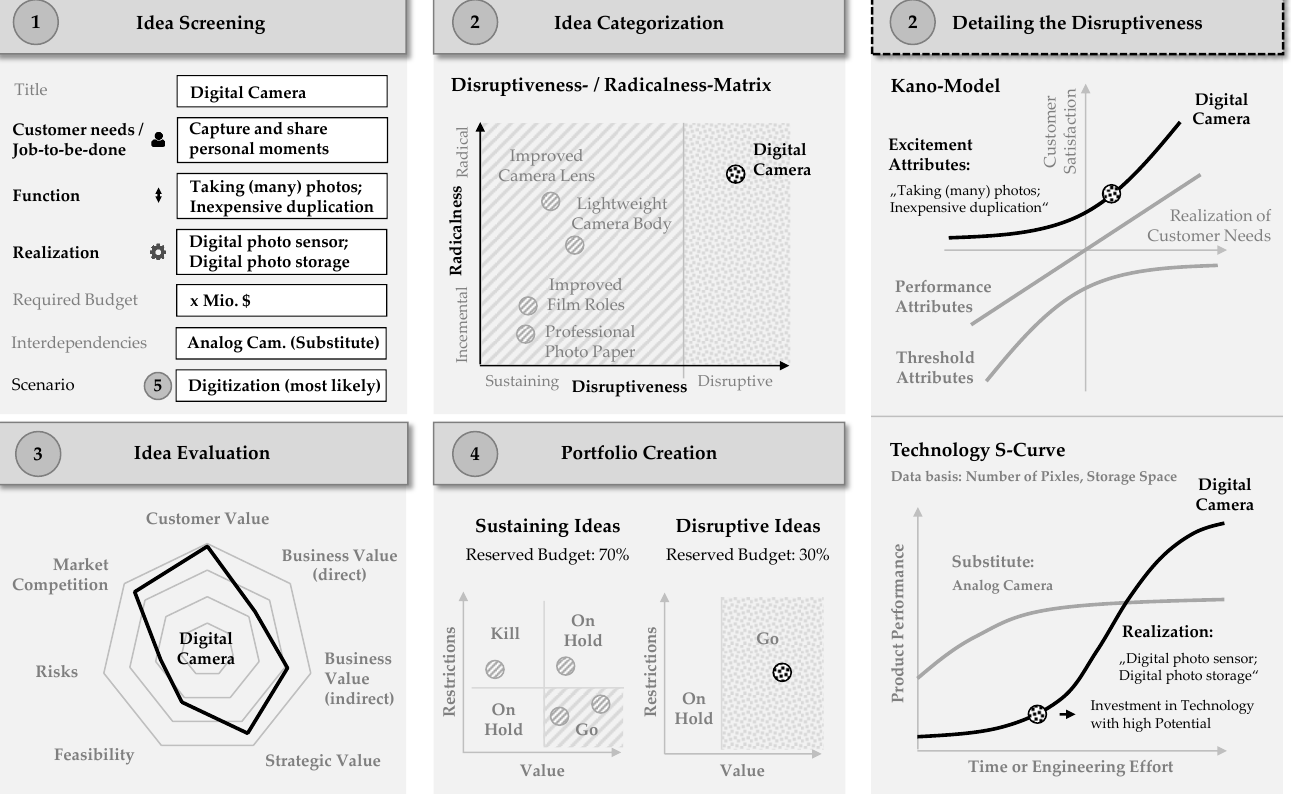
Figure 7. Support Evaluation of the proposed methodology by the example of the digital camera.